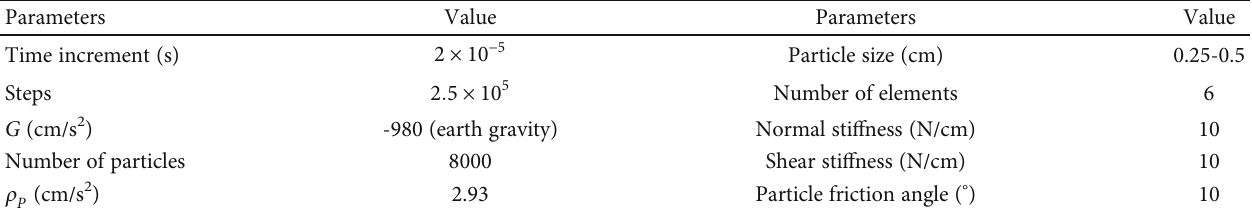
Figure 5: Replacement and sedimentation for lunar soil simulant. Table 2: Microscopic parameters selected for simulation of FJS-1 in loose